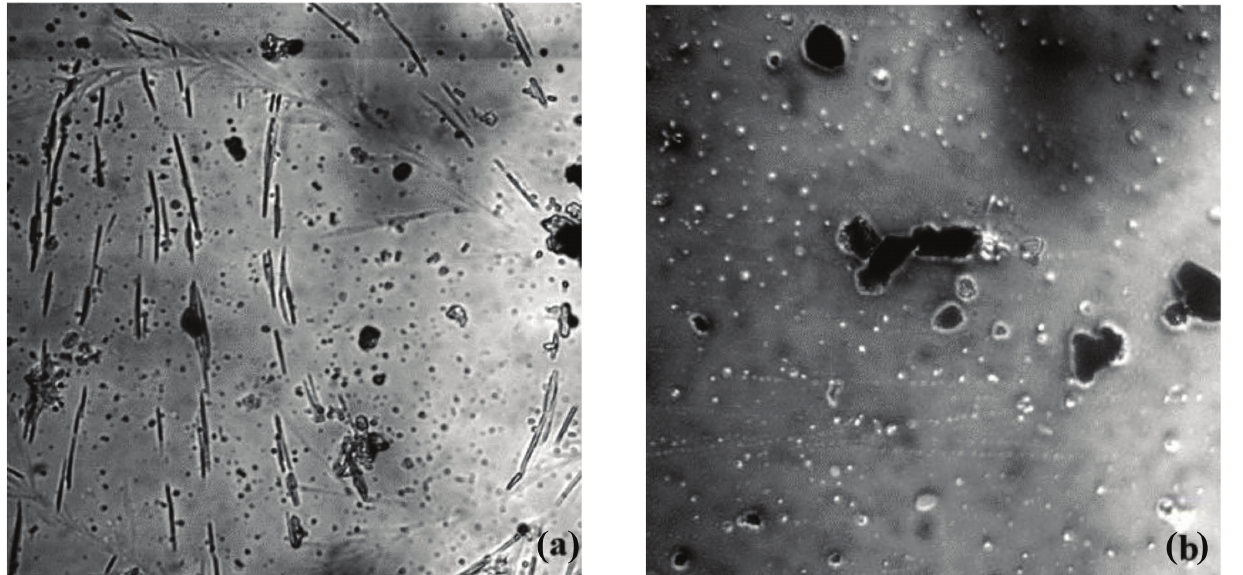
Fig. 7 – Image recorded with a confocal microscope under: a) 100x, and b) 500x magnification, ISM 75 %. This technique was used to characterize the surface topography of the coal after spraying it with the plant-based dust